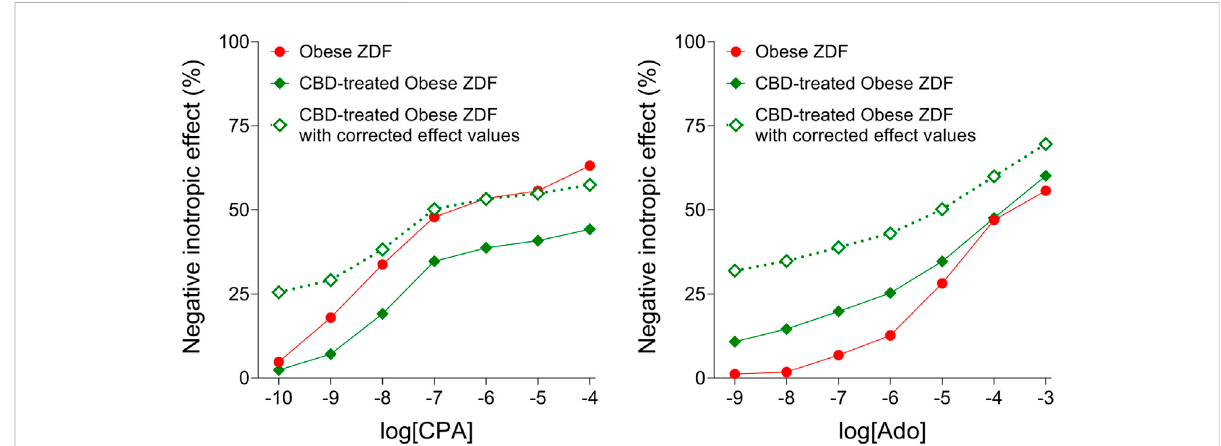
The corrected effect values of the averaged CPA and adenosine concentration-response (E/c) curves of the CBD-treated Obese ZDF group, furthermore the original (inherently correct) effect values of the averaged CPA and adenosine E/c curves of the Obese ZDF group (treated with vehicle).The x -axisshowsthecommonlogarithmofthemolarconcentrationofthegivenagonist(inthebathing medium),whilethe y -axisindicates the effect (as a percentage decrease of the initial contractile force). The symbols represent the responses to the given agonist averaged within the groups. CPA: N 6 -cyclopentyladenosine; Ado: adenosine; CBD: cannabidiol; ZDF: Zucker Diabetic